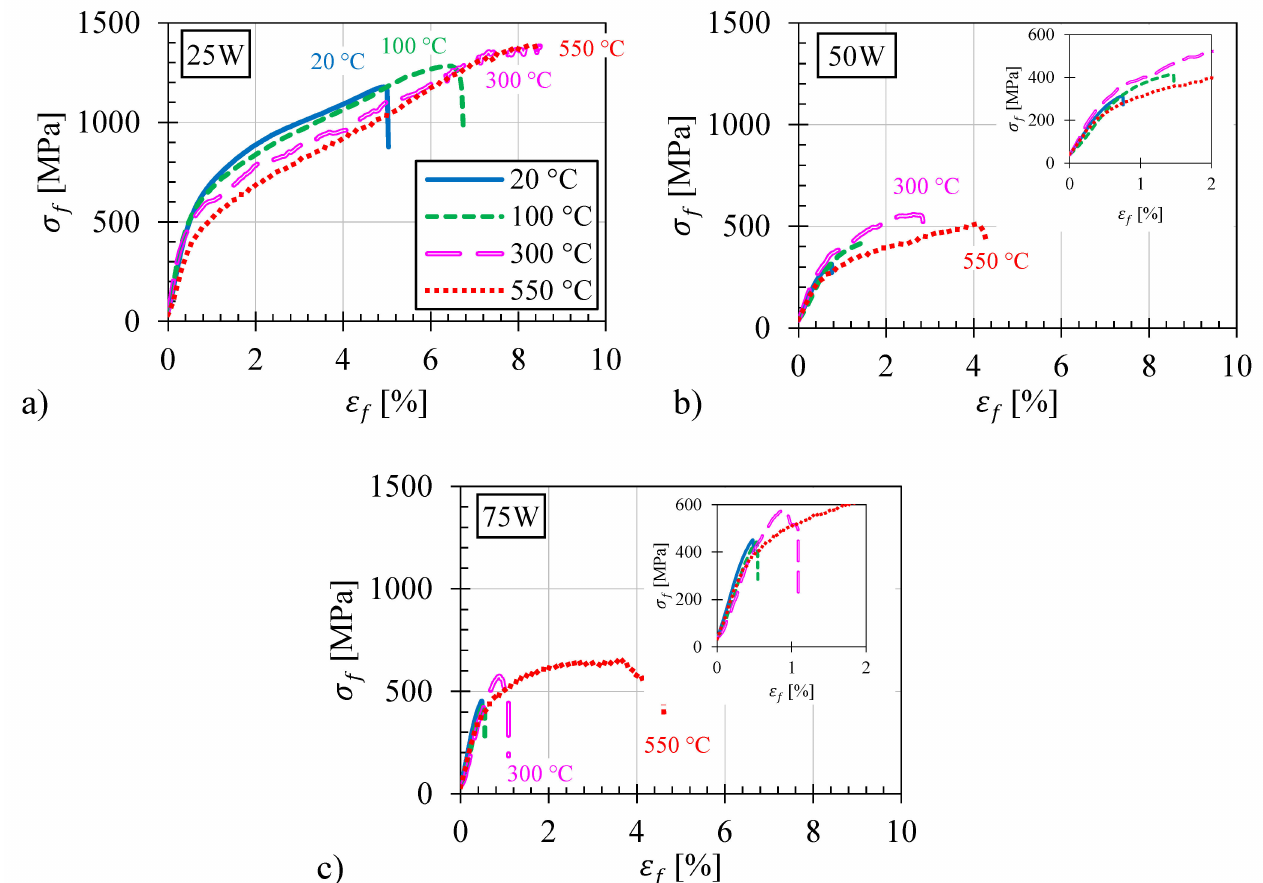
Figure 8. Flexural stress vs strain curves for: ( a ) 25 W; ( b ) 50 W; ( c ) 75 W